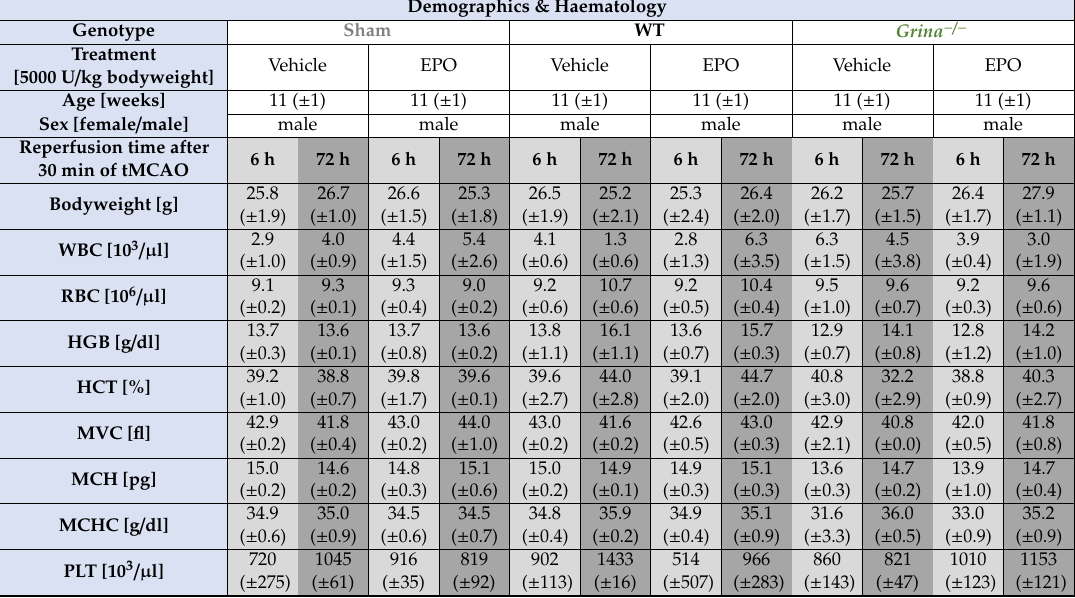
Table 1. Demographics and haematology of all genotypes and treatment groups after 30 min of tMCAo followed by 6 and 72 h of